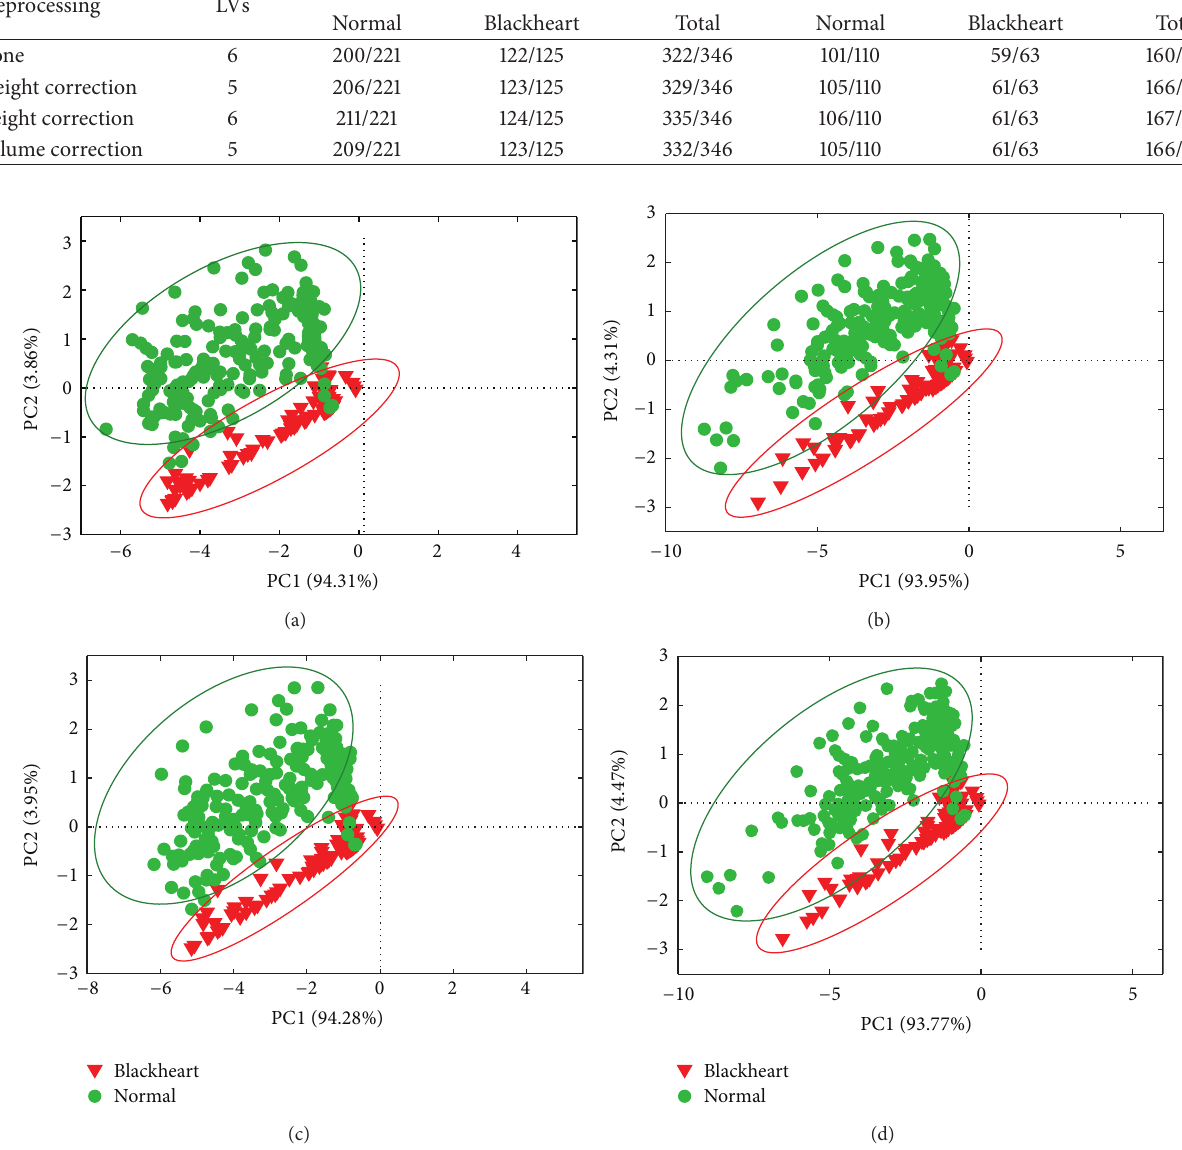
Figure 5: Score plots of the first and second principal components of PCA using 1800 variables: (a) raw transmittance; (b) weight correction transmittance; (c) height correction transmittance; (d) volume correction